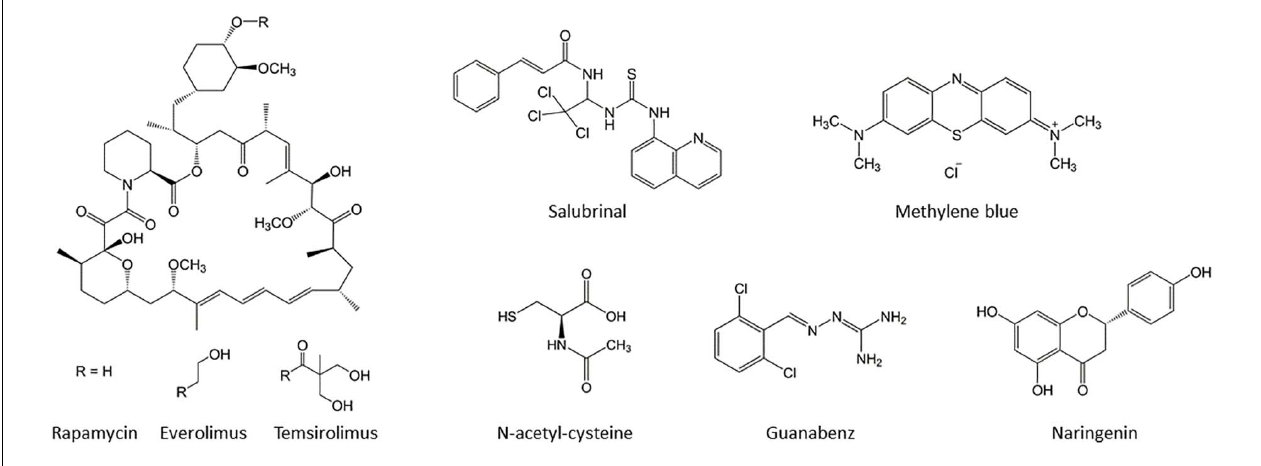
FIGURE 2 | Chemical structure of the molecules that could be considered for the treatment of HSP